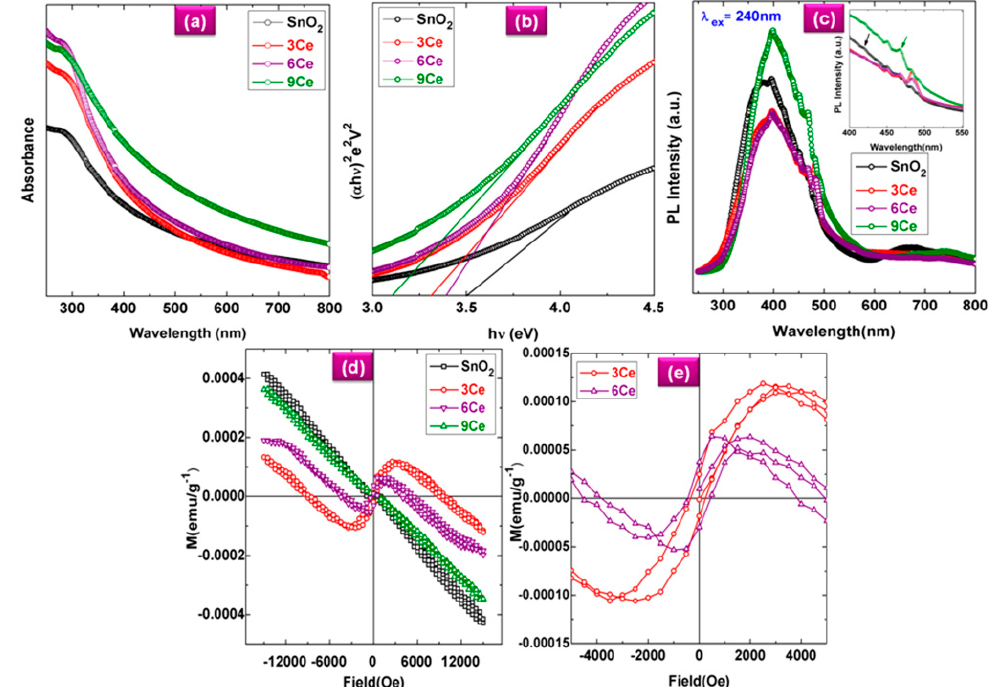
Figure 11. UV-vis absorption spectra ( a ) and Tauc-plot ( b ) of undoped and Ce-doped SnO 2 hollow nanofibers, ( c ) photoluminescence (PL) spectra of 0, 3, 6, and 9 mol. % Ce-doped SnO 2 hollow nanofibers, ( d ) M–H curves of 0, 3, 6, and 9 mol. % Ce-doped SnO 2 hollow nanofibers (at 300 K), and ( e ) extended view of the M–H curve of 3 and 6 mol. % Ce-doped SnO 2 hollow nanofibers (Reproduced with permission from [34]. AIP Publishing LLC, 2017).